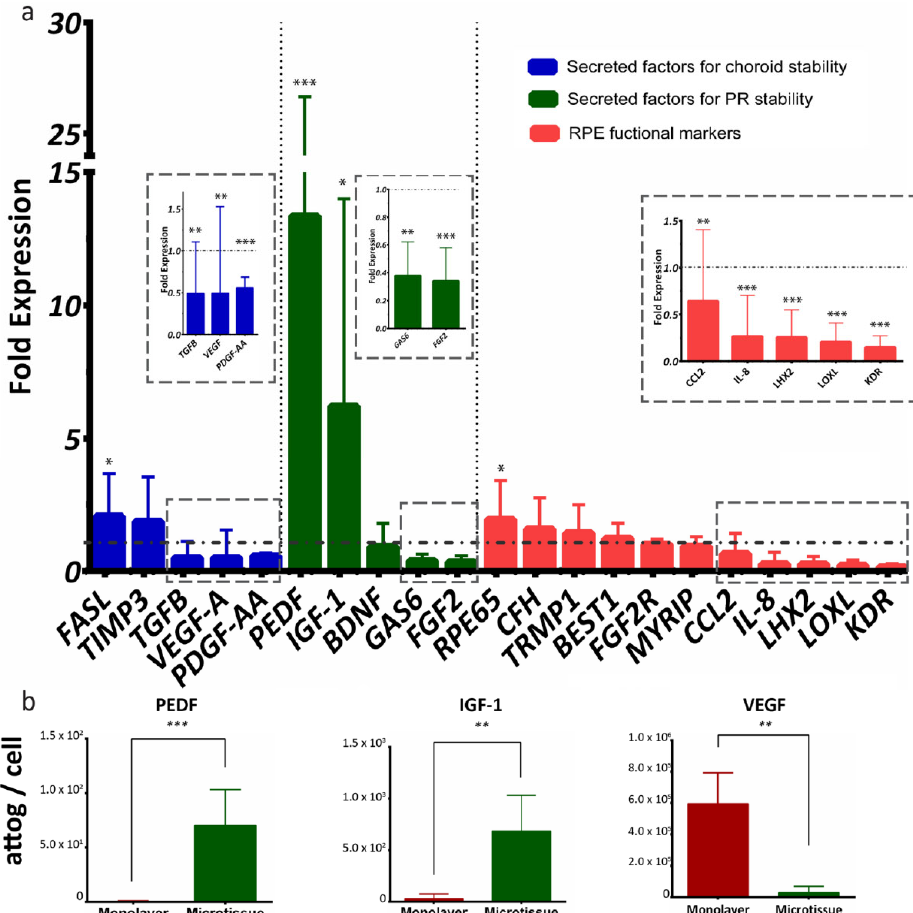
Figure 4. ARPE-19 RPE- µ Ts upregulate the expression of desirable photoreceptor trophic factors. ( a ) RT-qPCR was conducted to compare the expression profile of key genes between our 3D RPE- µ Ts and standard adherent culture of ARPE-19 (n = 8–13). The results are presented as “fold expression” values to showcase the extent of expression enhancement of certain genes in our RPE- µ Ts (bar graphs) compared to adherent culture (dotted line), with gene expression normalized to an endogenous reference gene (CNTF). A Wilcoxon matched-pairs signed-ranks test was used to compare ∆ Ct values between RPE- µ Ts and adherent culture for each gene. ( b ) Conditioned media was analyzed for levels of secreted PEDF, IGF-1 and VEGF and statistical significance determined by using a Mann–Whitney U test (n = 5); * p < 0.05, ** p < 0.01, *** p < 0.001. Error bars represent standard